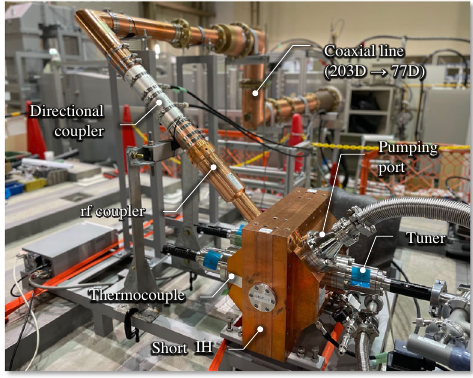
FIG. 10. Photograph of the experimental apparatus of the high- power test of the short